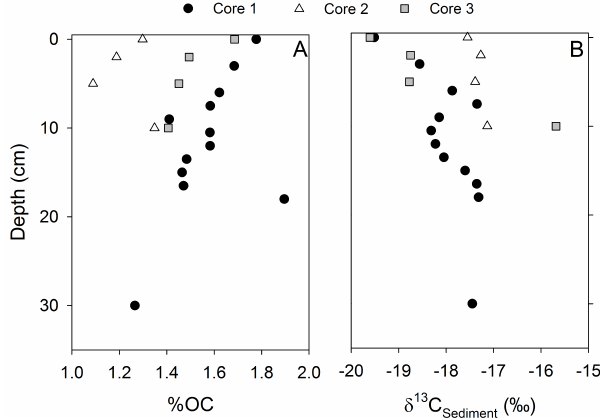
Fig. 6. Plots of (A) δ 13 C POC vs. δ 13 C DOC throughout the Tana River Basin, (B) δ 13 C soil vs. δ 13 C POC and δ 13 C DOC for tributaries along Tana River Basin (i.e. mainstream data not included in panel B ).